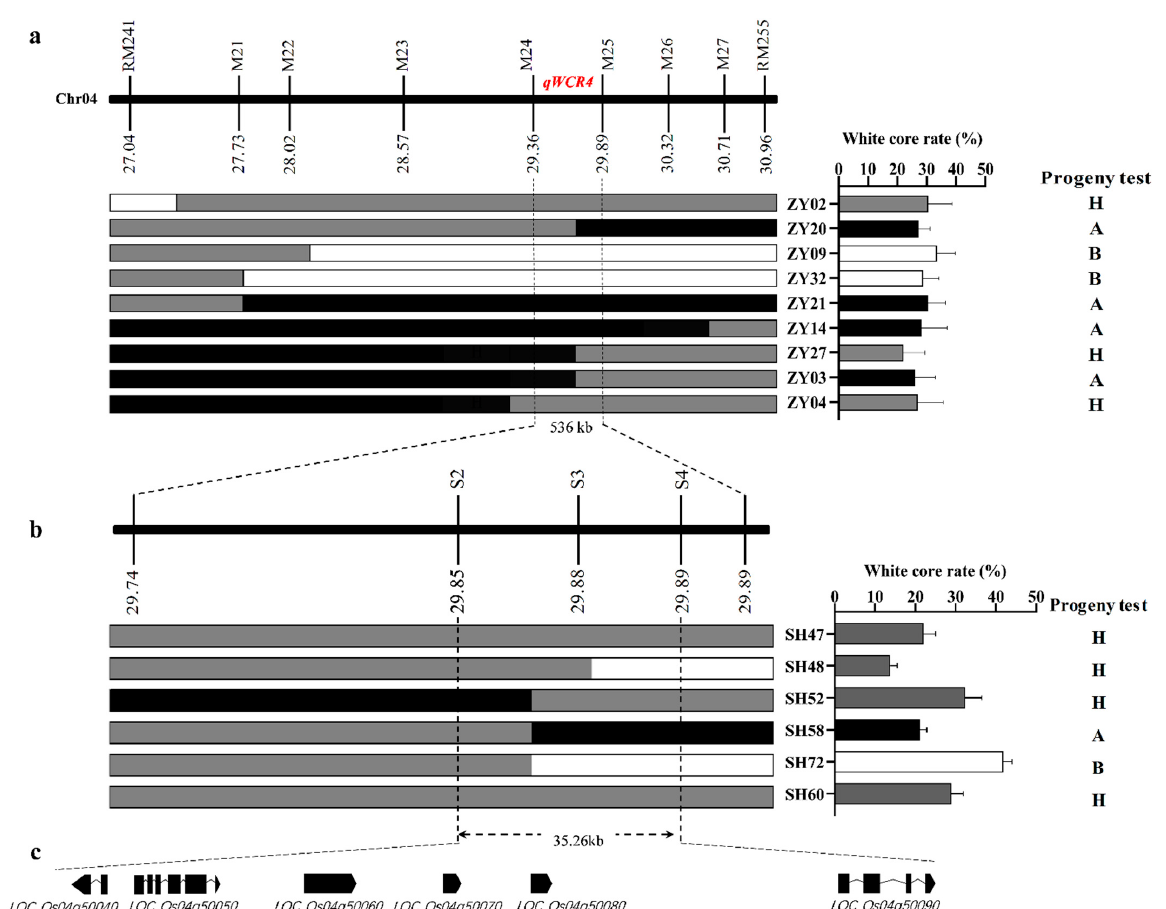
Figure 2. Fine mapping of qWCR4 . ( a ) The first-step fine mapping of qWCR4 . ( b ) The second-step fine mapping of qWCR4 . ( c ) Schematic representation of candidate gene in qWCR4 region. Black, white, and grey blocks represent the genotypes of homozygous BL130, homozygous J23B, and heterozygote, respectively. Genotypes and phenotypes of recombinants, each of which was confirmed by progeny test, the A and B of the progeny test meant no WCR difference between two homologous plants in recombinant progeny, while the H of the progeny test meant significant WCR difference.